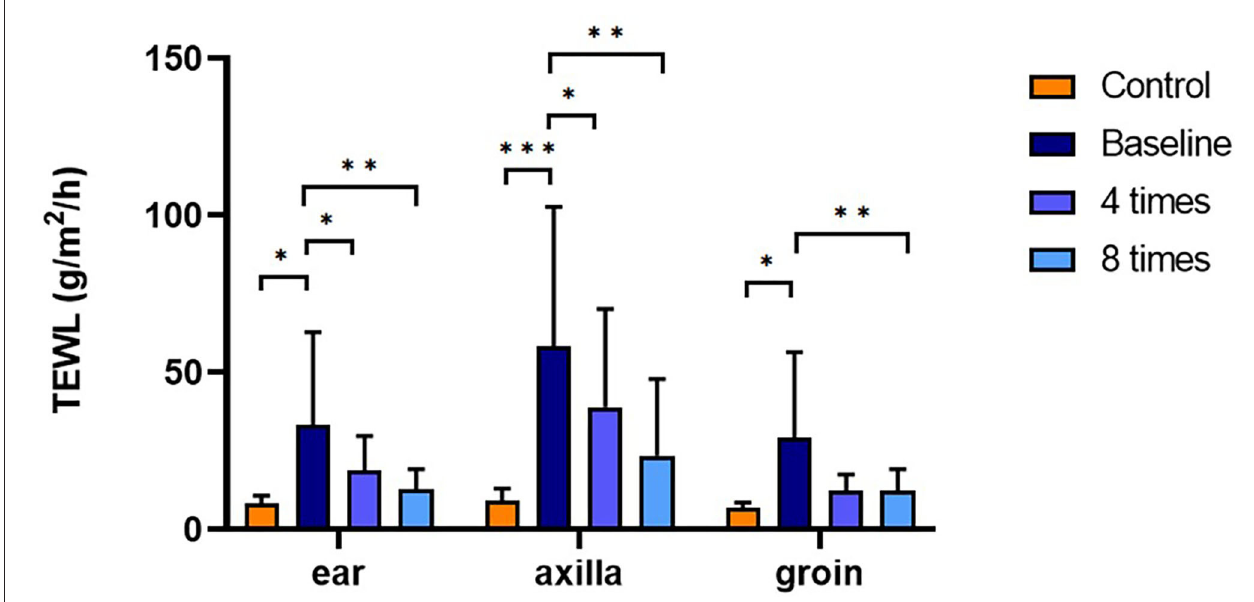
FIGURE 4 | Assessment of TEWL with excimer light therapy. Difference in the TEWL between the control and allergic groups and change in the TEWL in the allergic group with excimer light therapy. Four times, fourth session of excimer light therapy in allergic group; eight times, end of the excimer light therapy in the allergic group; baseline, before the start of excimer light therapy in the allergic group; TEWL, transepidermal water loss. All values are expressed as mean ± standard error. * P < 0.05, ** P < 0.01, *** P < 0.001.